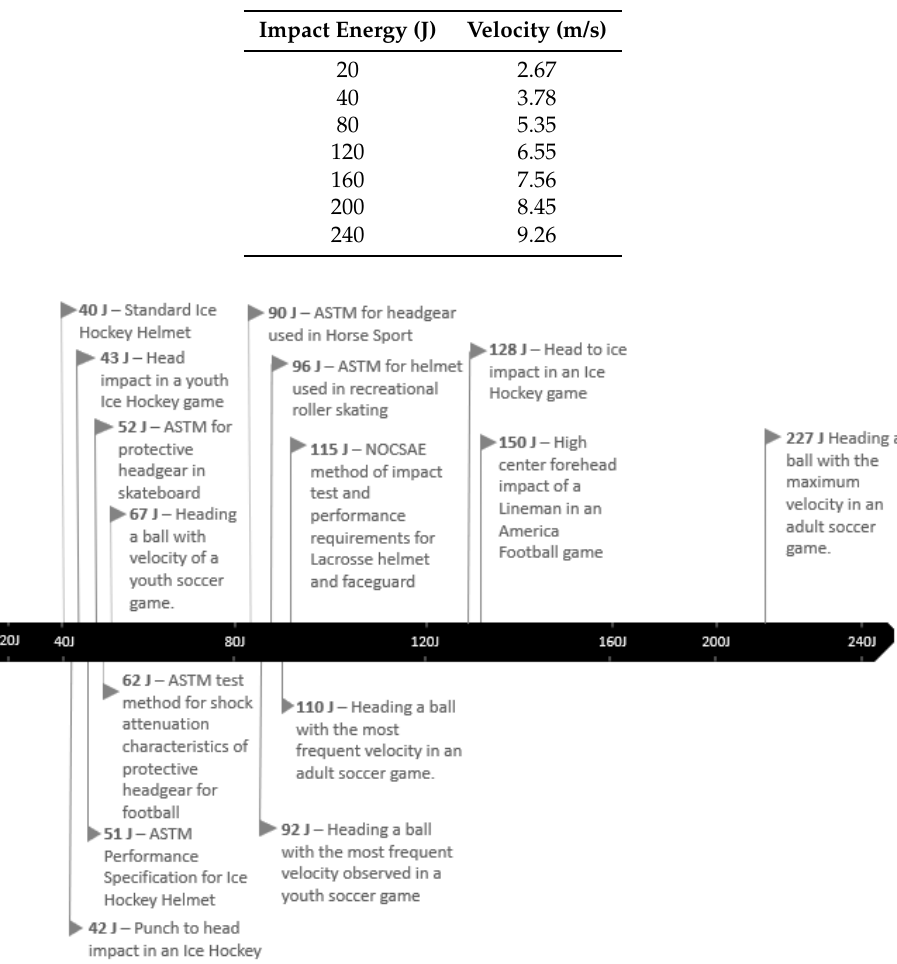
Table 9. Impact energy and velocity values.